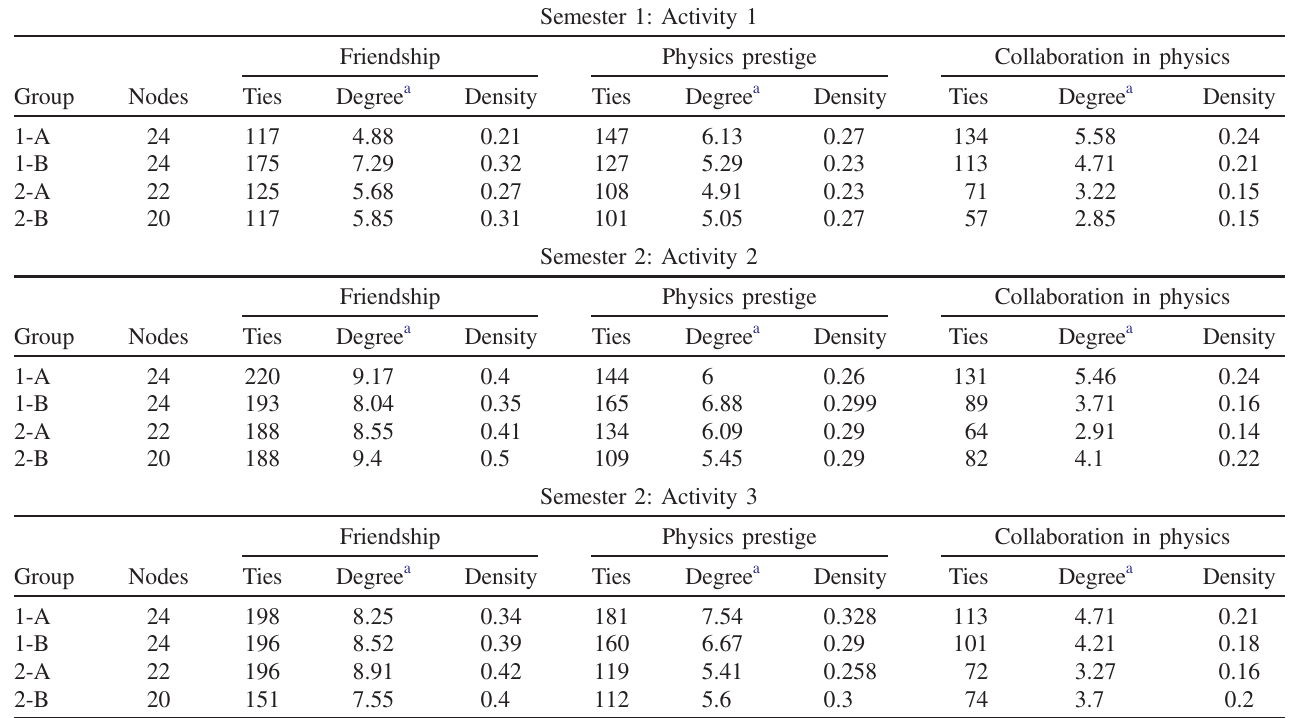
TABLE V. Descriptive statistics of directed networks in activities 1 at the end of semester 1, and activities 2 and 3 in semester 2: friendship ties, physics prestige nomination, and collaboration in